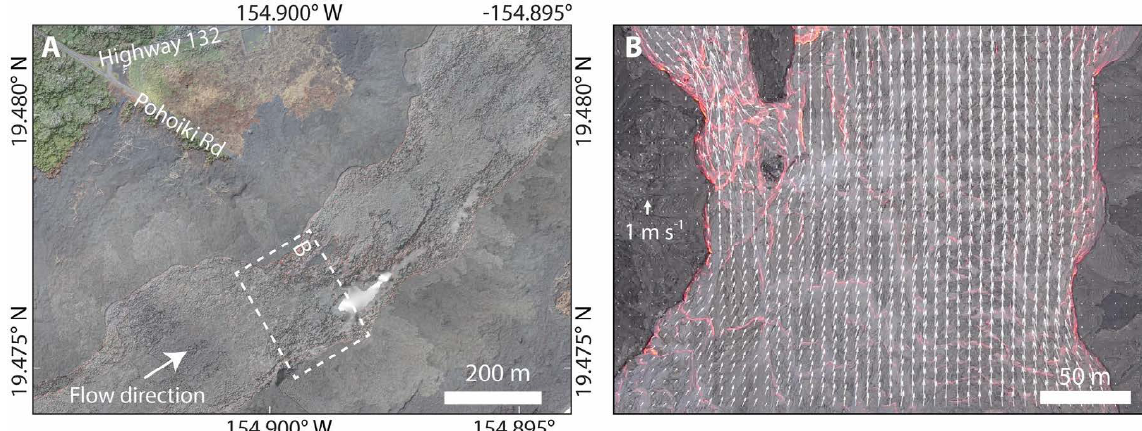
Figure 5: UAS imaging of active lava flows at K¯ılauea volcano, Hawai‘i. [A] Orthomosaic draped over a digital elevation model (DEM) of a section of the Fissure 8 channel of the 2018 Lower East Rift Zone eruption. UAS crew vehicles are visible on the road. Dashed rectangle outlines the location of [B], a segment of the Fissure 8 channel, overlaid by arrows indicating flow velocity magnitude and direction, computed using particle image velocimetry analysis on video acquired during UAS